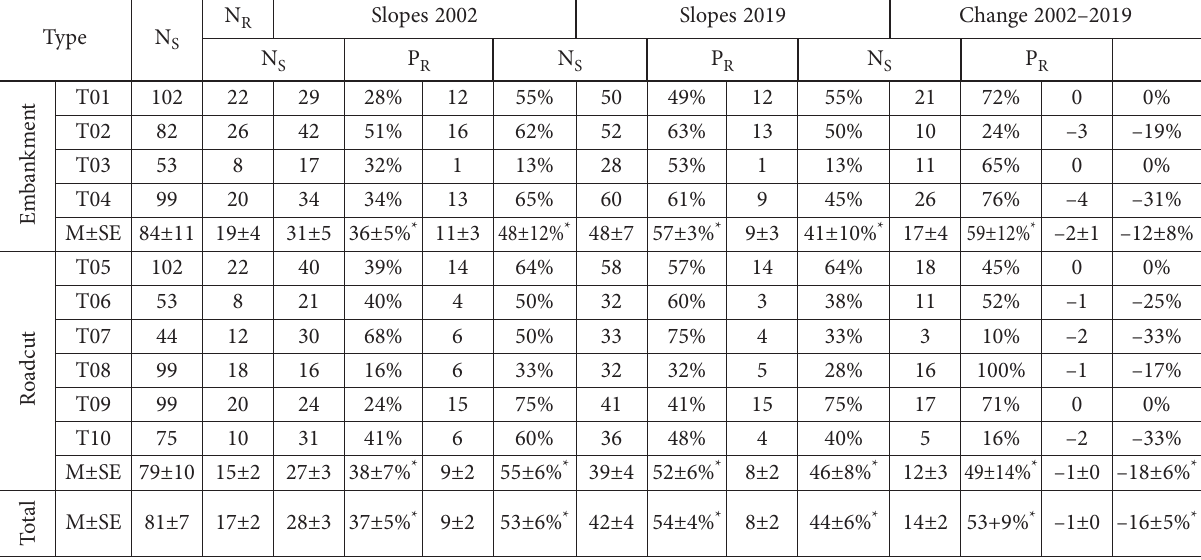
Table 4. Number of species in surrounding vegetation, revegetation and slope